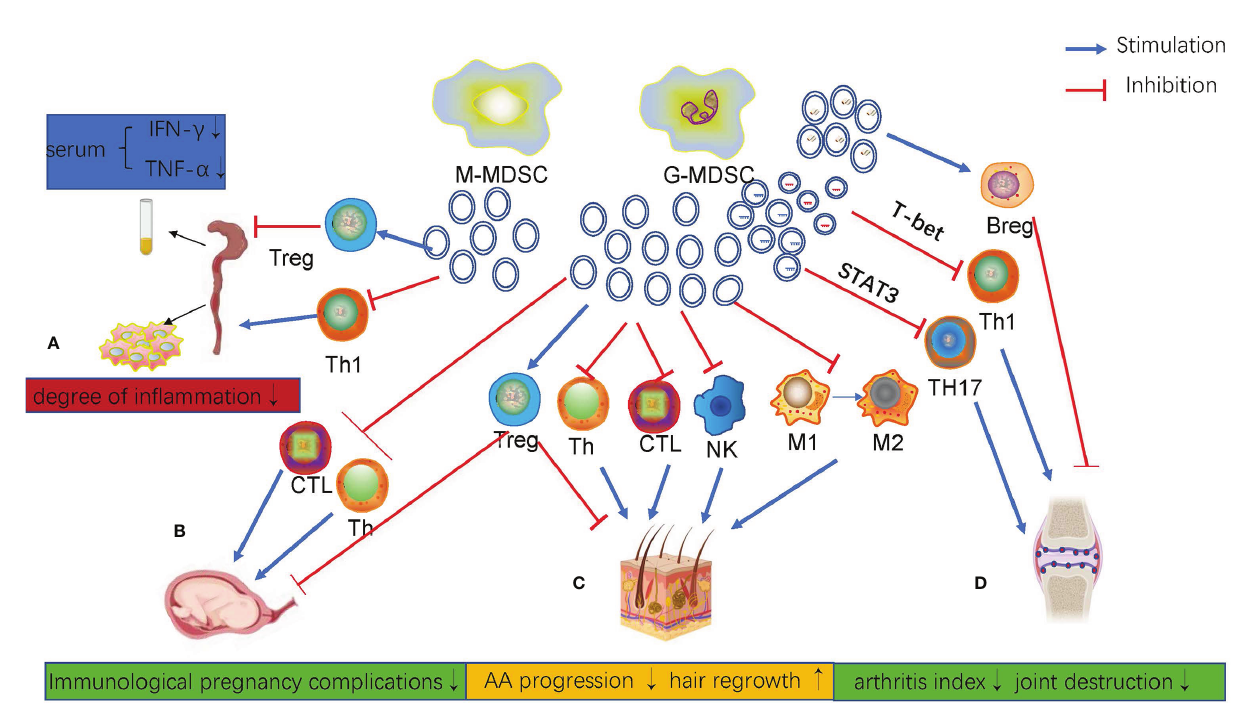
FIGURE 2 | (A) In DSS-induced colitis, G-MDSCs-Exos inhibited the proliferation of Th1 cells, promoted the proliferation of Treg cells, and decreased serum IFN-g and TNF-AIN levels in mice. (B) Maternal peripheral blood G-MDSCs-Exos regulated different subtypes of T cell differentiation and function. (C) MDSCs-Exos inhibited AA progression and promoted hair regrowth. (D) G-MDSCs-Exos attenuated CIA in mice by regulating Th1, Th17 and Breg